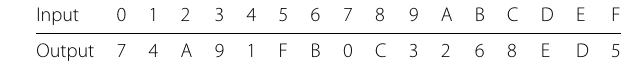
Table 2 The S-box used in KLEIN Input